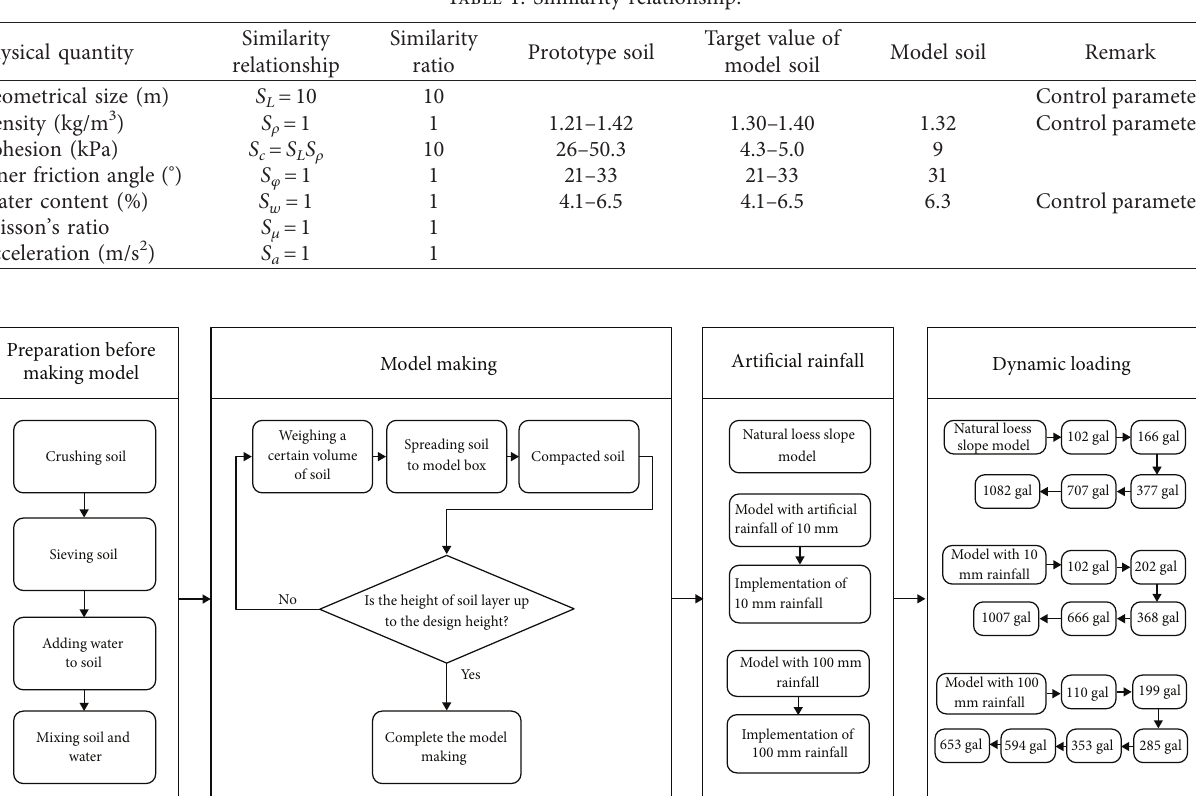
Figure 3: Flowchart of the shaking table model